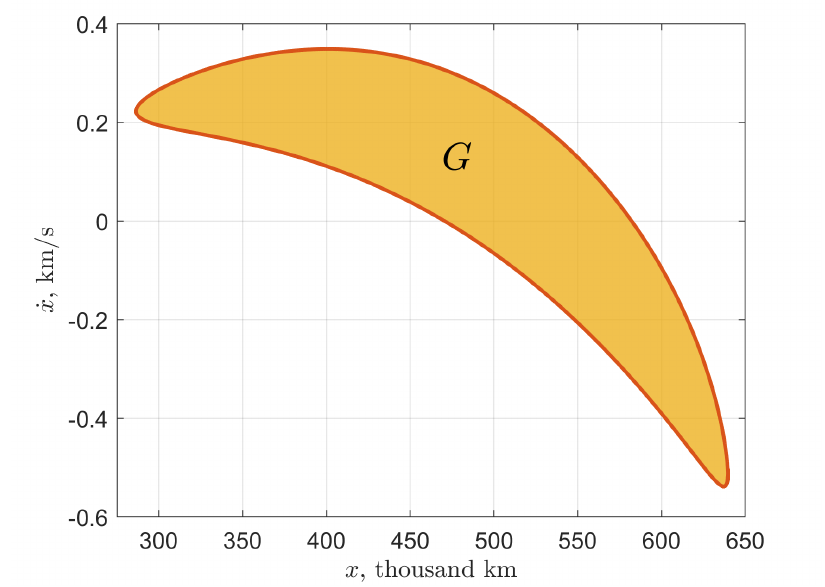
Figure 7. L 2 lunar gateway G in the ( x , ˙ x ) plane. The region is formed by stable manifold trajectories of the J = 3.06 planar Lyapunov orbit when crossing the Earth–Moon RoP